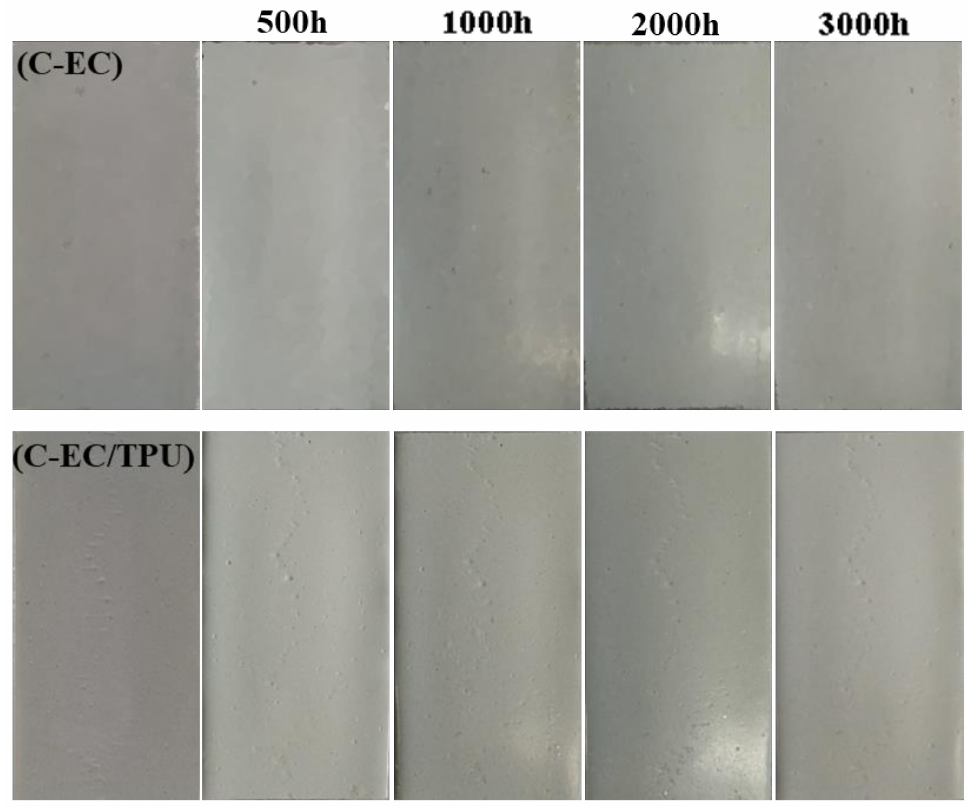
Figure 8. Surface morphology of sample after 500 h, 1000 h, 2000 h, and 3000 h salt spray test.